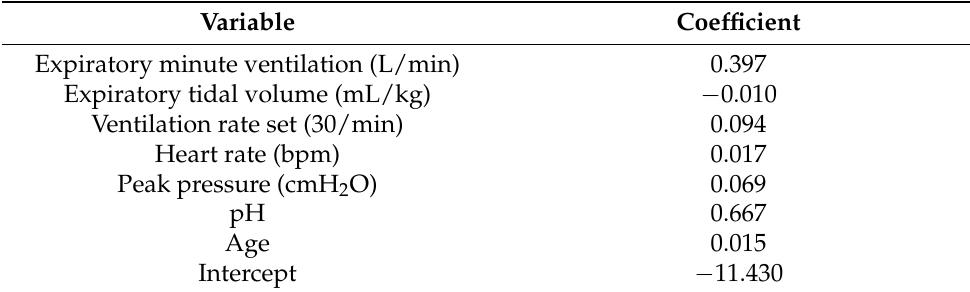
Table 3. Logistic regression coefficients of seven variables.